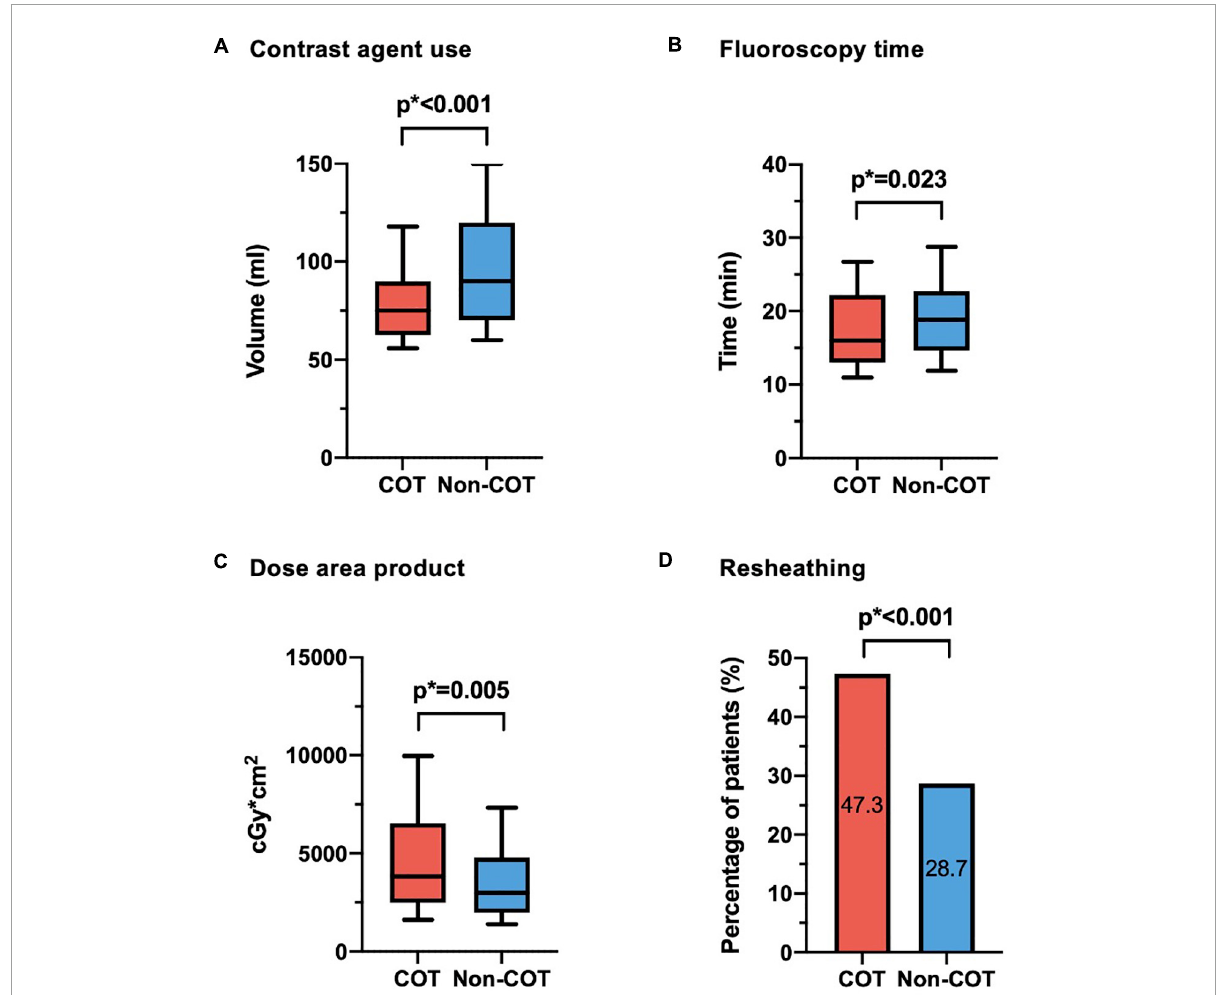
FIGURE3 Procedural data. (A) Reduction of contrast agent use could be achieved in COT patients (COT 82.8 ± 33.4 ml vs. Non-COT 96.9 ± 33.6 ml; p < 0.001). (B) While fluoroscopy time was shorter (COT 18.4 ± 7.6 min vs. Non-COT 19.8 ± 7.6 ml; p = 0.023), (C) radiation dose area product was enhanced in the COT group (COT 4,951 ± 3,662 Gy × cm 2 vs. Non-COT 3,875 ± 2,775 Gy × cm 2 ; p = 0.005), probably due to more extreme angulations and (D) notably higher rates of device resheathing maneuvers (COT 47.3% vs. Non-COT 28.7%; p < 0.001) compared to the Non-COT group. COT, cusp-overlap technique.